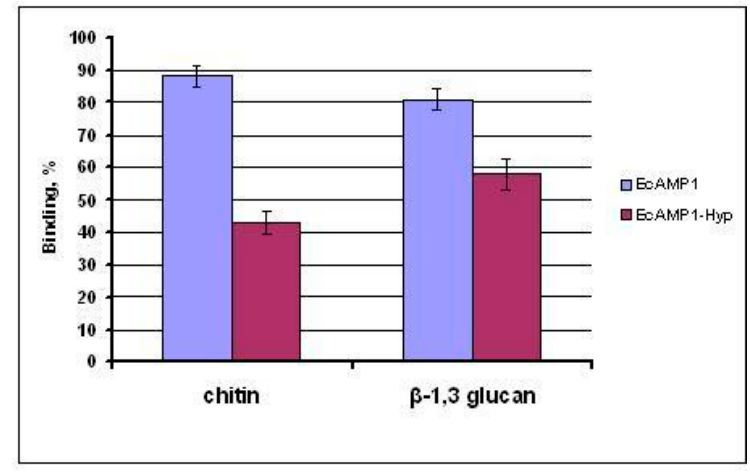
Figure 7. Quantitative in vitro binding of the EcAMP1 and the EcAMP1-Hyp with commercial